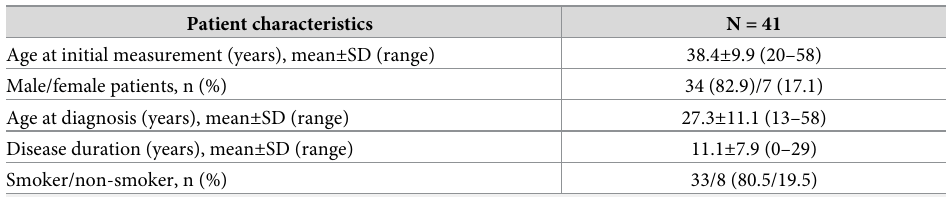
Table 1. Baseline characteristics of patients with Crohn